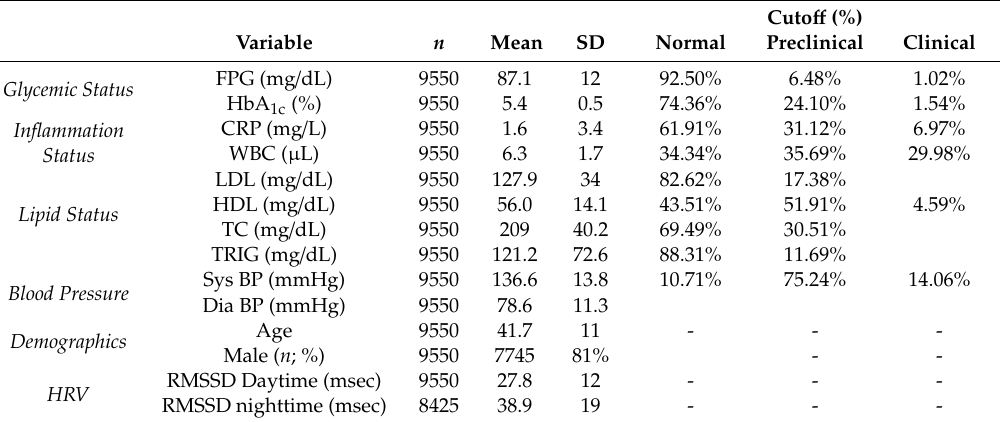
Table 2. Classification of biomarkers into (clinical)